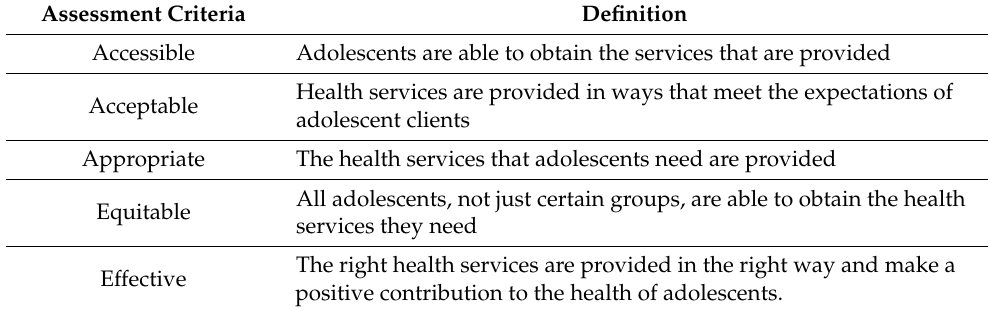
Table 1. Assessment